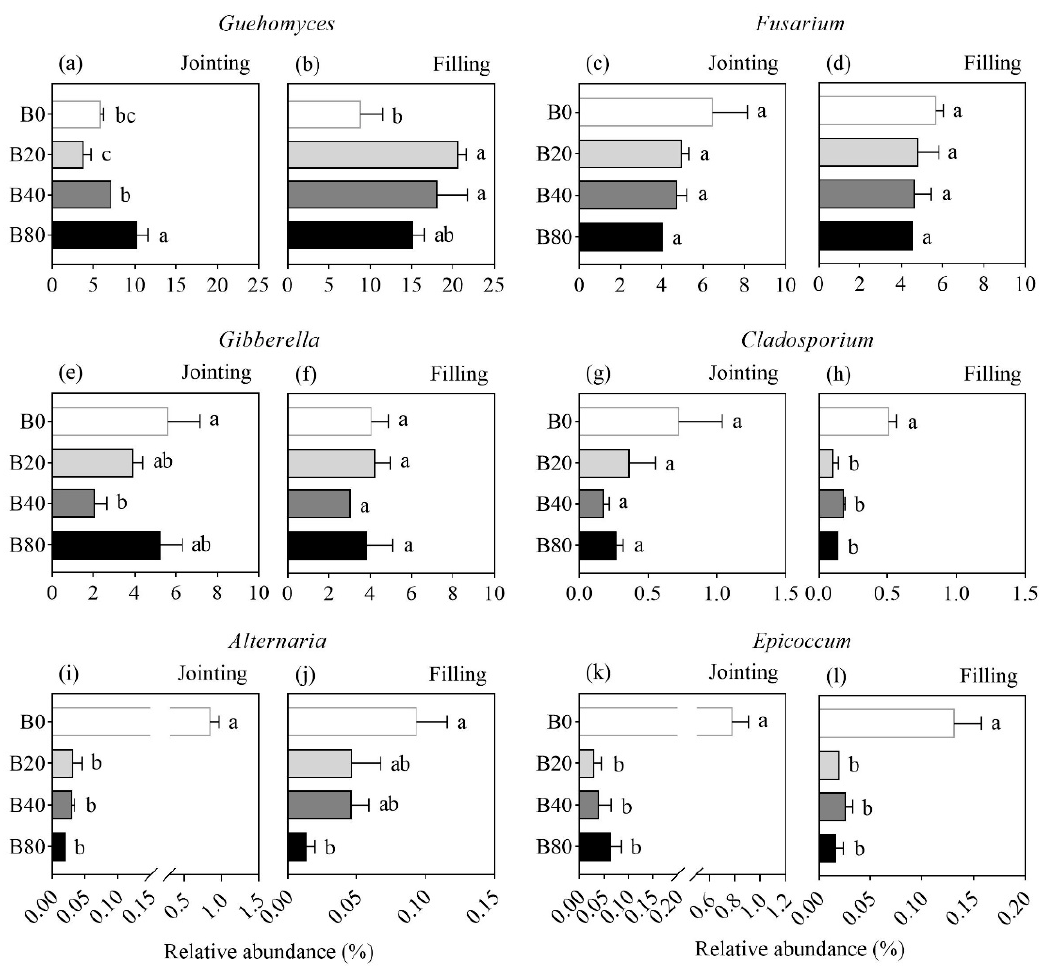
Figure 3. Effects of biochar on relative abundances of soil fungal genera. Note: Different letters indicate significant differences (one-way ANOVA, p < 0.05, Duncan analysis).